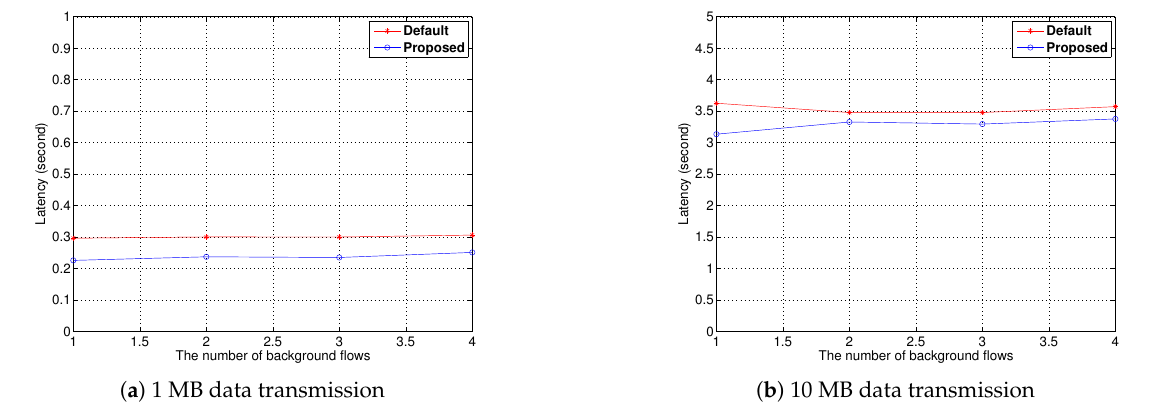
Figure 15. Transmission latency for different background flows with dumbbell topology. ( a ) 1 MB and ( b ) 10 MB data